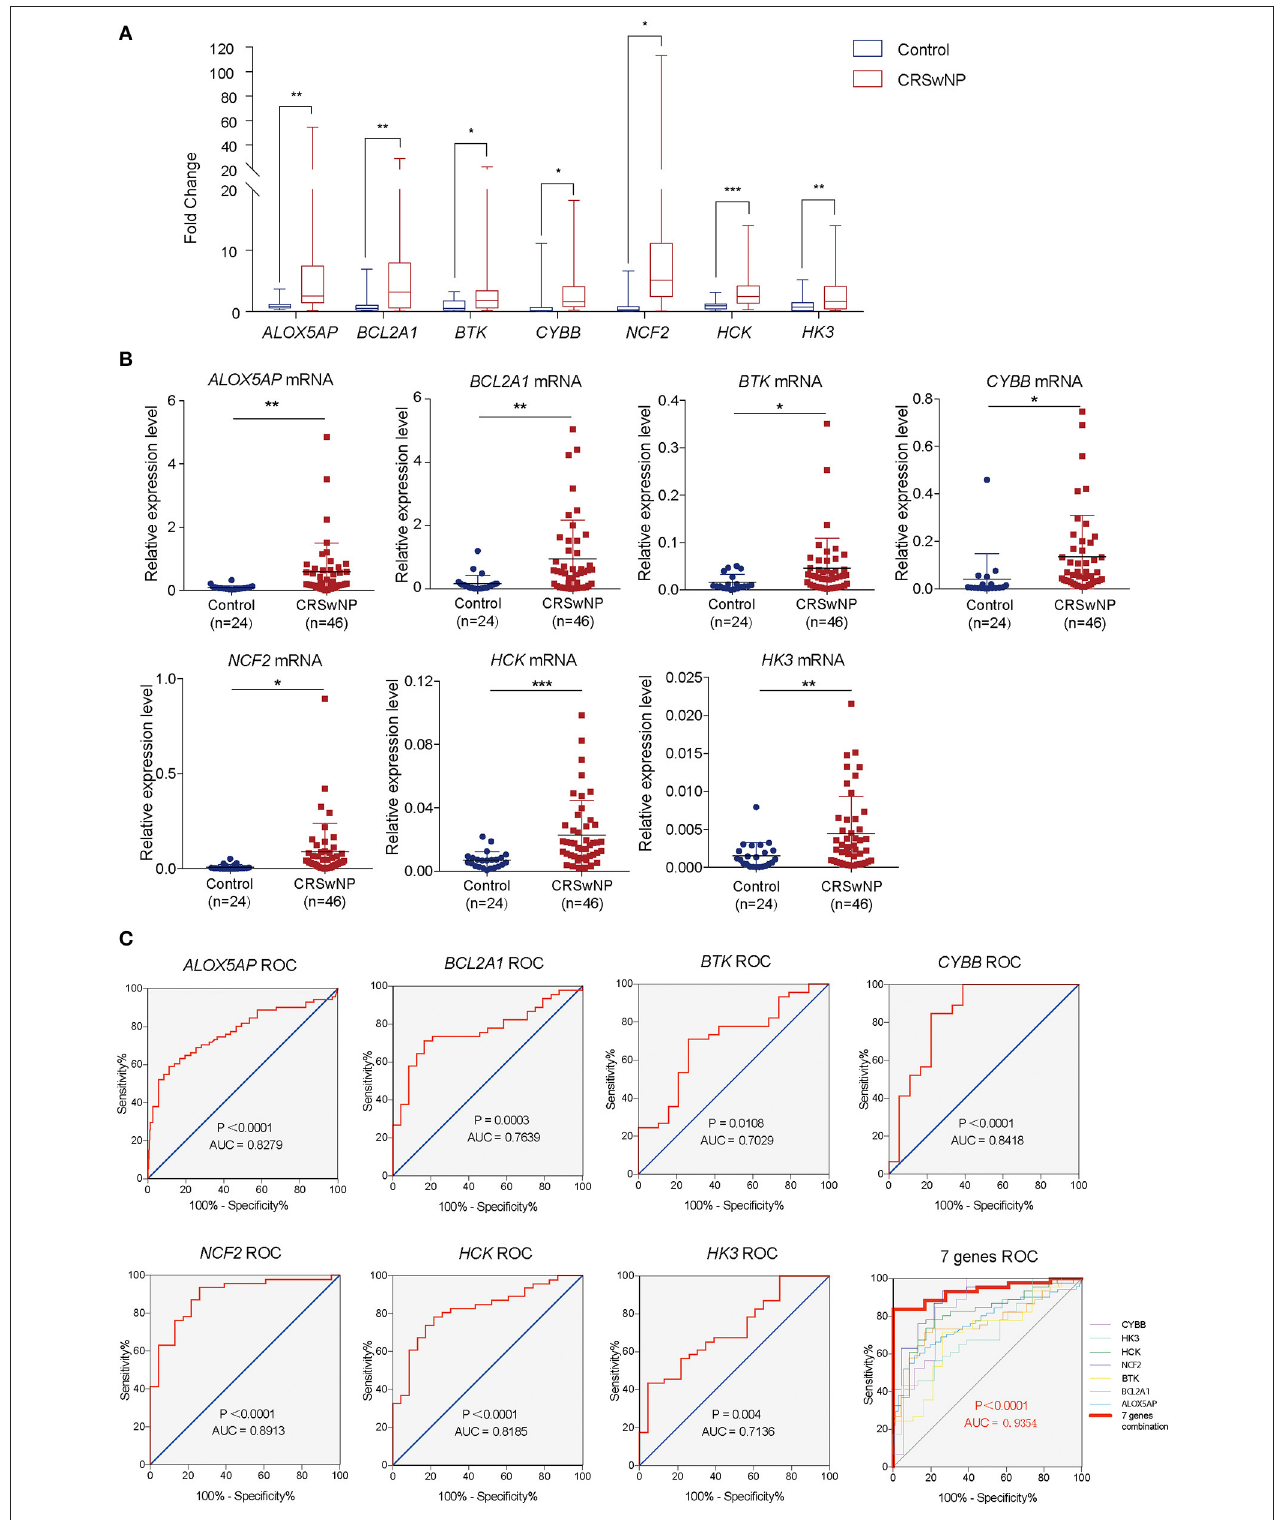
FIGURE 4 | The gene expression levels and diagnostic values of 7 hub genes in CRSwNP. (A) Fold changes in the ALOX5AP, BCL2A1, BTK, CYBB, NCF2, HCK , and HK3 genes in CRSwNP as determined by RT-qPCR. (B) The relative expression levels of the ALOX5AP, BCL2A1, BTK, CYBB, NCF2, HCK , and HK3 genes in CRSwNP. GAPDH was used as a reference. (C) ROC curves for testing the hub genes ALOX5AP, BCL2A1, BTK, CYBB, NCF2, HCK , HK3, and the combination of 7 hub genes as determined by RT-qPCR. * P < 0.05, ** P < 0.01, *** P < 0.001.